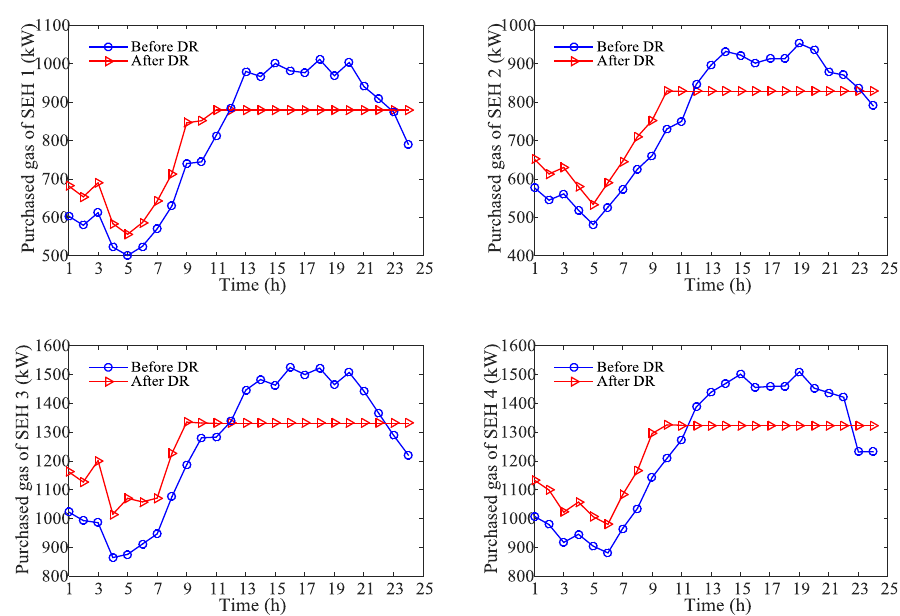
Figure 8. Hourly gas demands of all EHs before and after DR.